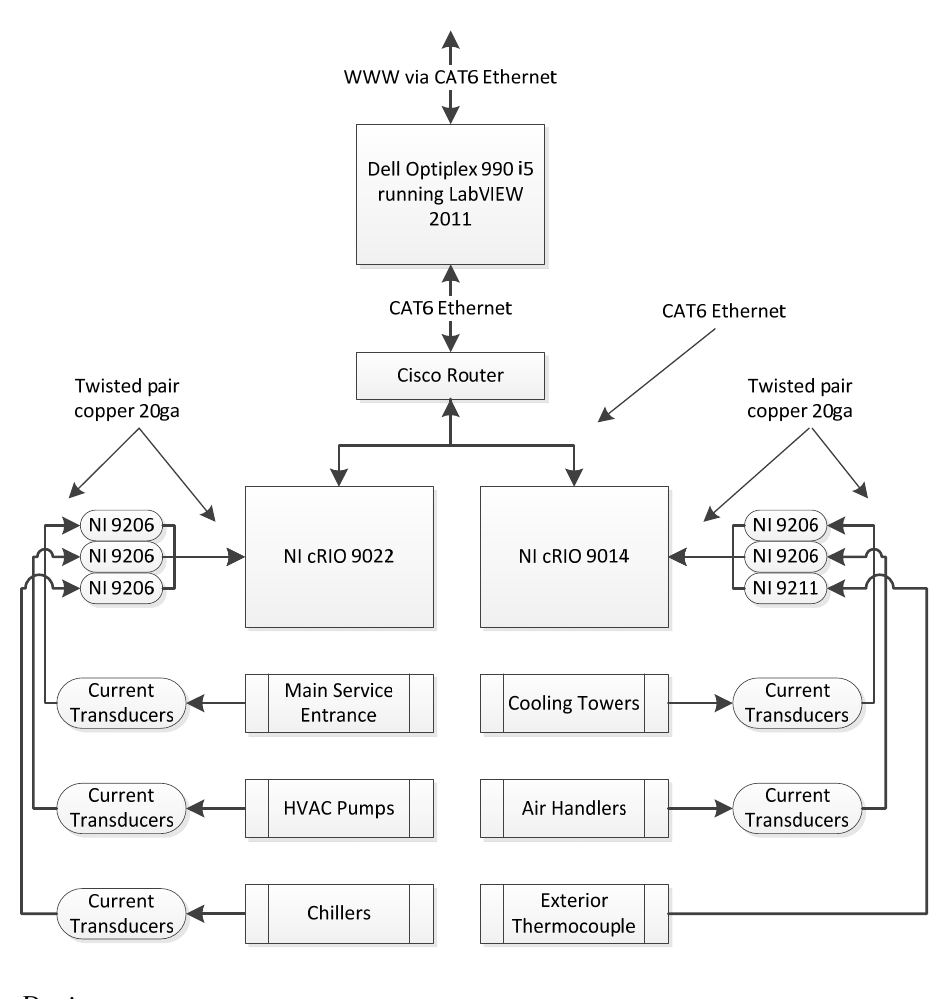
Figure 2. National Instruments hardware